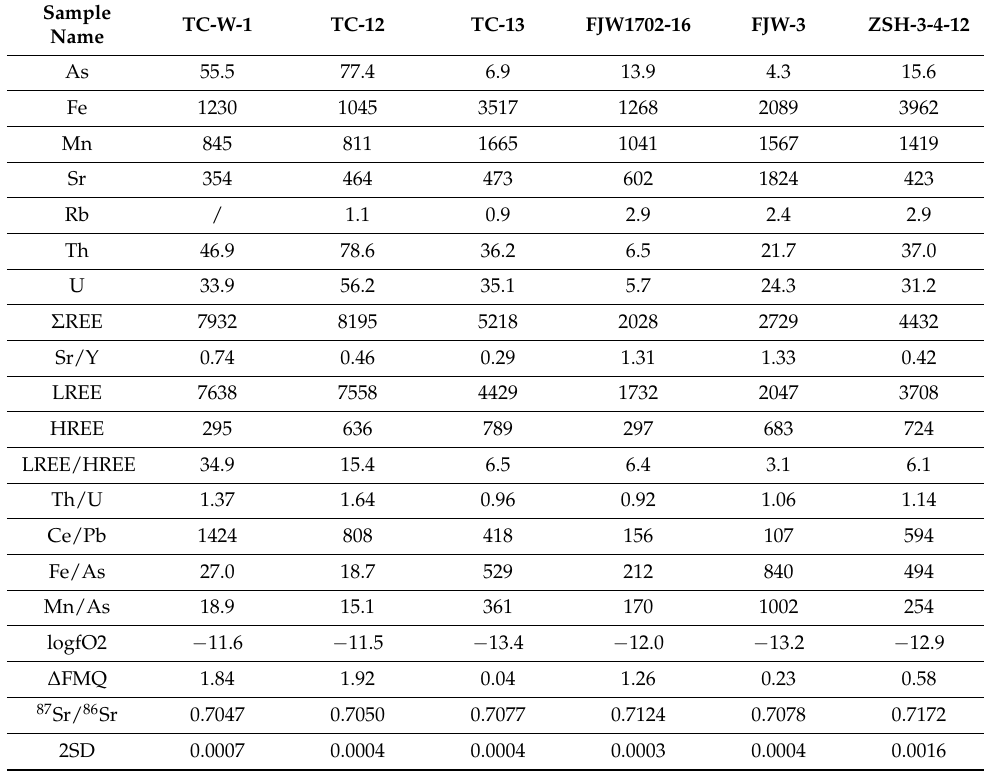
Table 4. Summary of the apatite trace elements, F/Cl, LREE, and Sr isotope data.